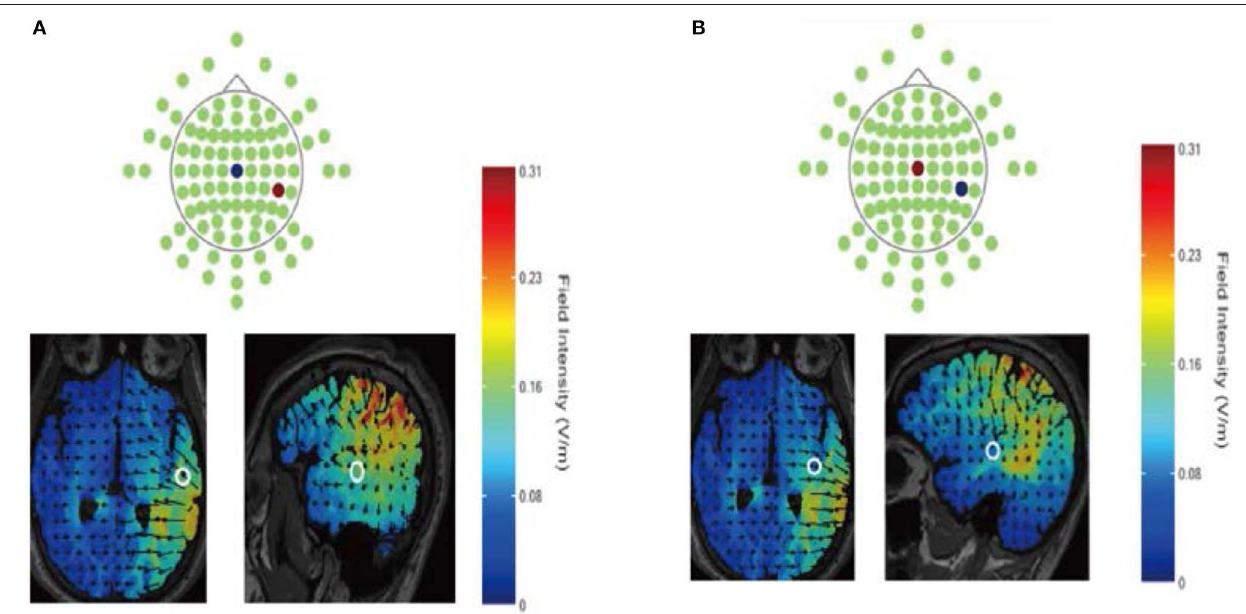
FIGURE 1 | Direct current flow during anodal (A) or cathodal (B) stimulation using the HD-Explore software (Soterix Medical Inc., New York). Electrodes were placed over the CP6 and Cz according to the International EEG 10–10 system. The anode is depicted in red; the cathode is depicted in